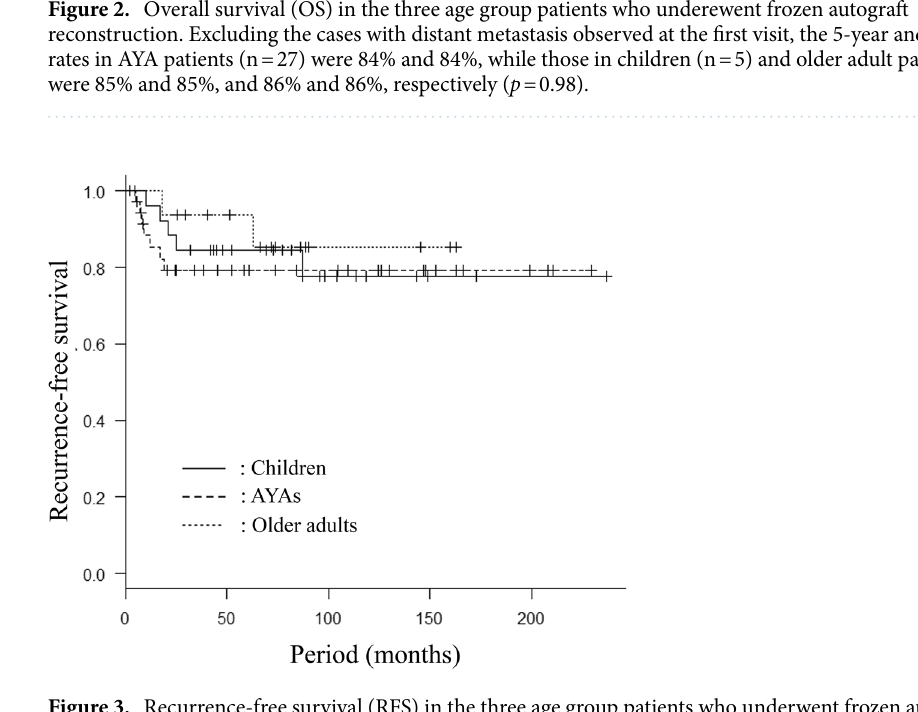
Figure 3. Recurrence-free survival (RFS) in the three age group patients who underwent frozen autograft reconstruction. The 5- and 10-year RFS rates in AYA patients (n = 37) were 79% and 79%, while those in children (n = 27) and older adult patients (n = 16) were 85% and 78%, and 94% and 85%, respectively ( p =